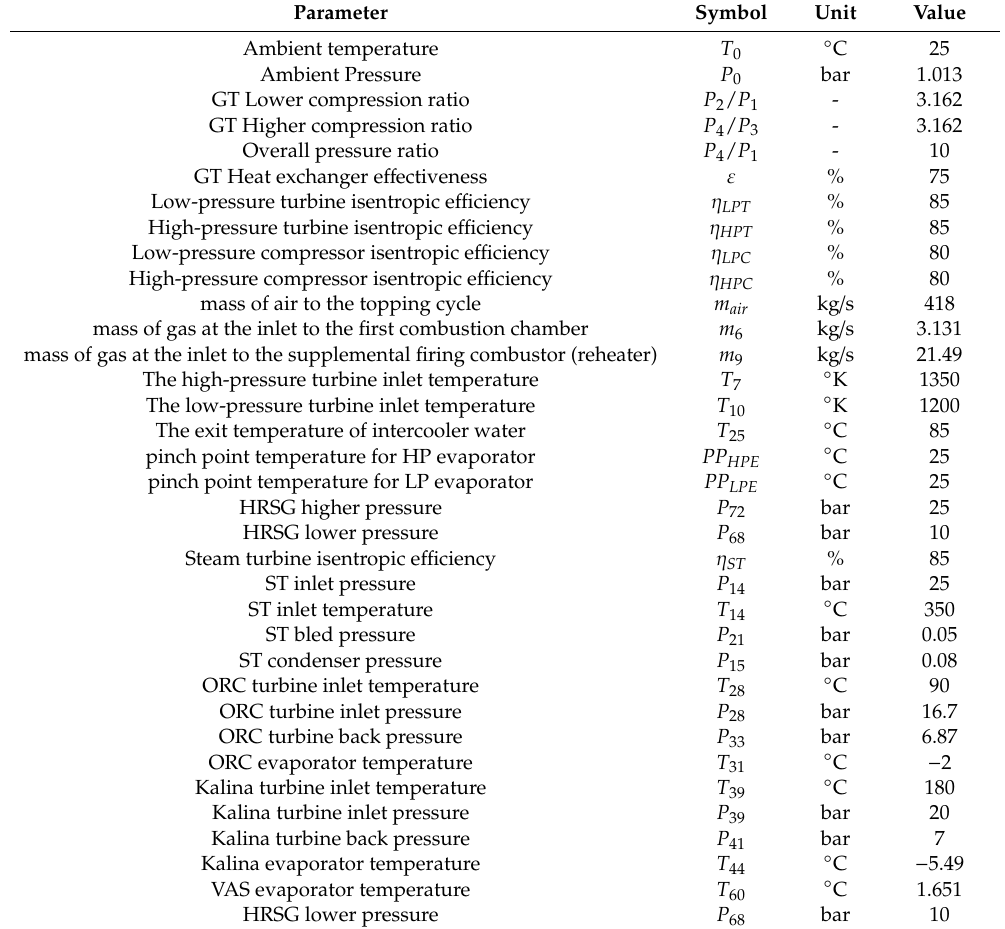
Table 2. Thermodynamic input parameters and simulation data for the proposed integrated multi-generation plant (IMP)